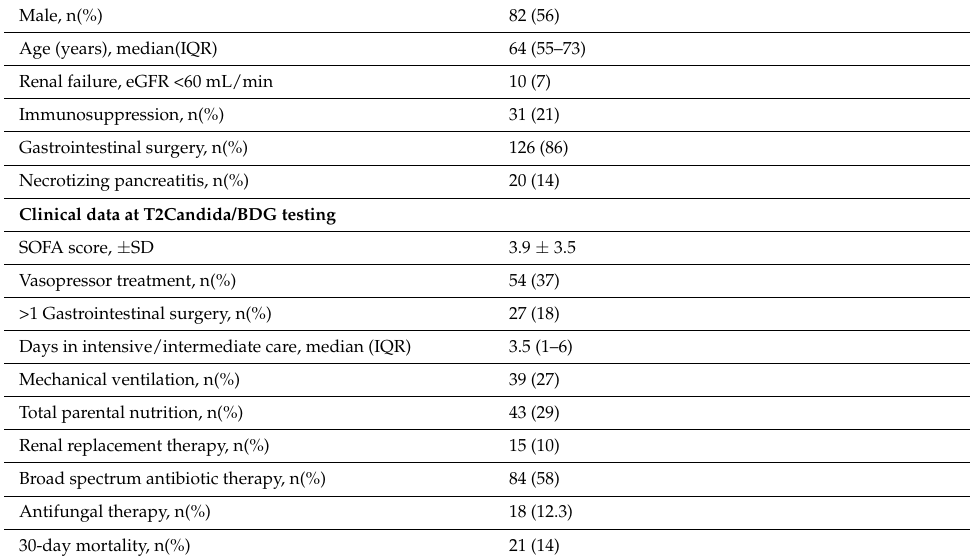
Table 1. Baseline characteristics, n =